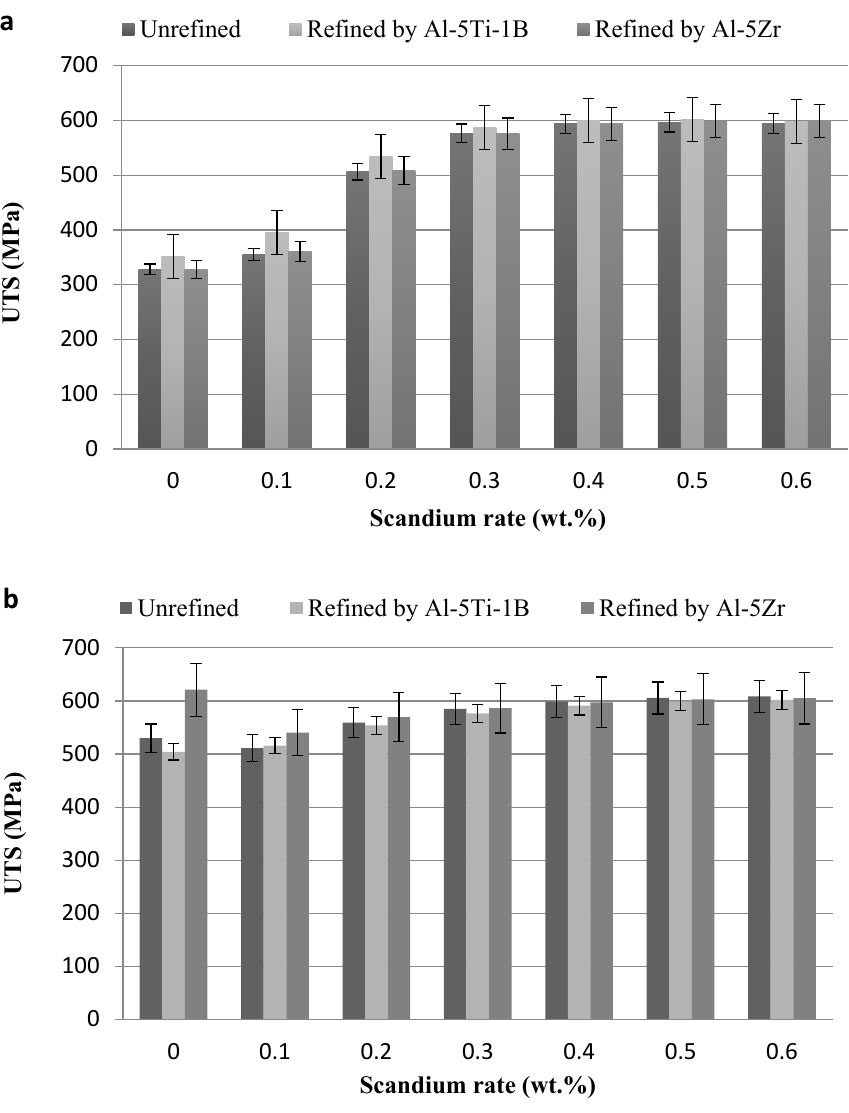
Figure 2. Effect of Sc rate on UTS of Al-Zn-Mg-Cu alloys: ( a ) non heat treatment ( b ) heat